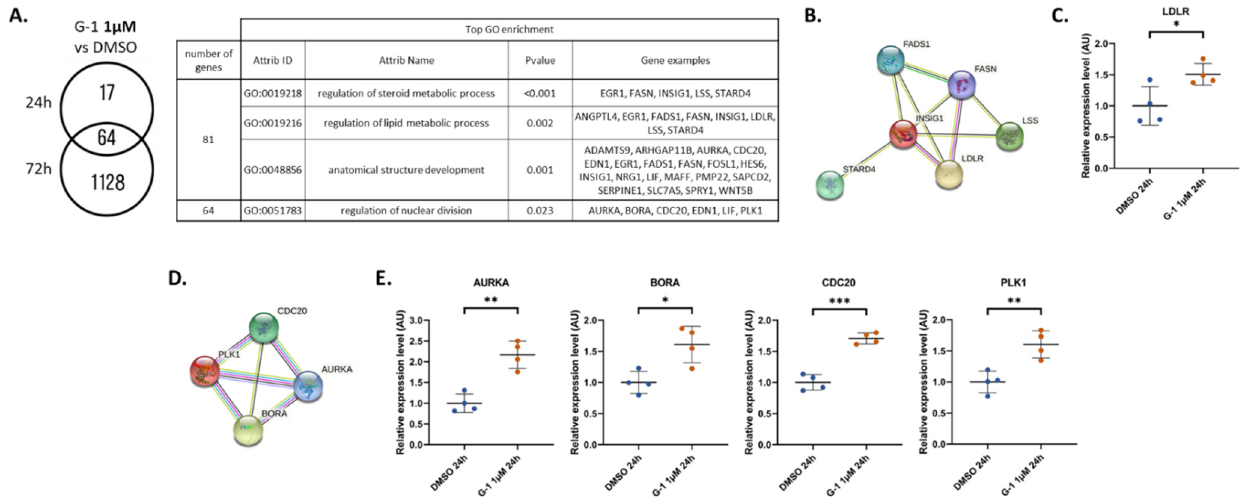
Figure 5. ( A ) Number of vehicle versus G-1 1 µ M DEGs and table of associated functions at 24 h and 72 h. ( B ) Protein–protein interactions from the STRING interaction database. Among the 17 DEGs selected after 24 h exposure to G-1 1 µM, the cluster FADS1, FASN, LSS, LDLR, INSIG1, and STARD4 was identified. ( C ) RT-qPCR analysis of LDLR expression in the RADH87 primary GBM cell line after 24 h of G-1 1 µM exposure ( D ) Protein–protein interactions from the STRING interaction database. Among the 64 common DEGs selected after 24 h and 72 h exposure to G-1 1 µM, the cluster CDC20, PLK1, AURKA, and BORA was identified. ( E ) RT-qPCR analysis of PLK1 , BORA , AURKA , and CDC20 expressions in the RADH87 primary GBM cell line after 24 h of G-1 1 µM exposure. Data are presented as the mean ± SD. Significance level was determined using t -tests, where *** indicates p < 0.001, ** indicates p < 0.01, and * indicates p < 0.05; n = 4.